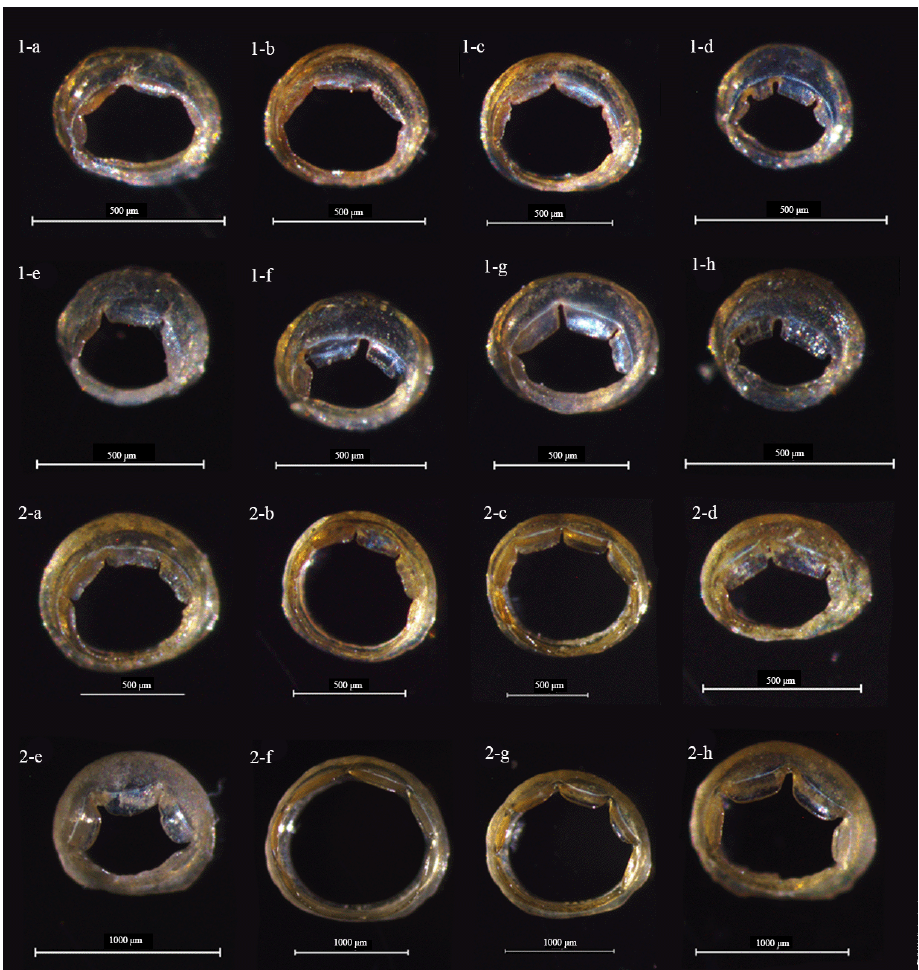
Figure 5. Sucker rings of L. ( N. ) beka . (Note: 1: Lineage A; 2: Lineage B; a: Arm I sucker ring ( ♀ ); b: Arm II sucker ring ( ); c: Arm III sucker ring ( ); d: Arm Ⅳ sucker ring ( ); e: Arm I sucker ring ( ); ♀ ♀ ♀ ♂ f: Arm II sucker ring ( ); g: Arm III sucker ring ( ); and h: Arm Ⅳ sucker ring ( )). ♂ ♂ ♂